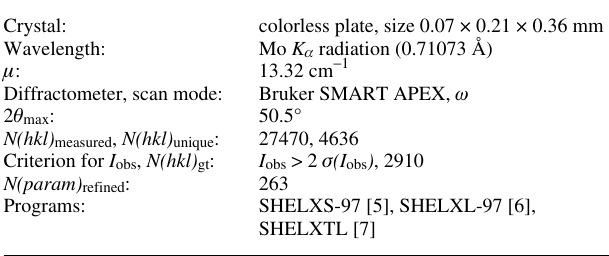
Table 1. Data collection and handling.